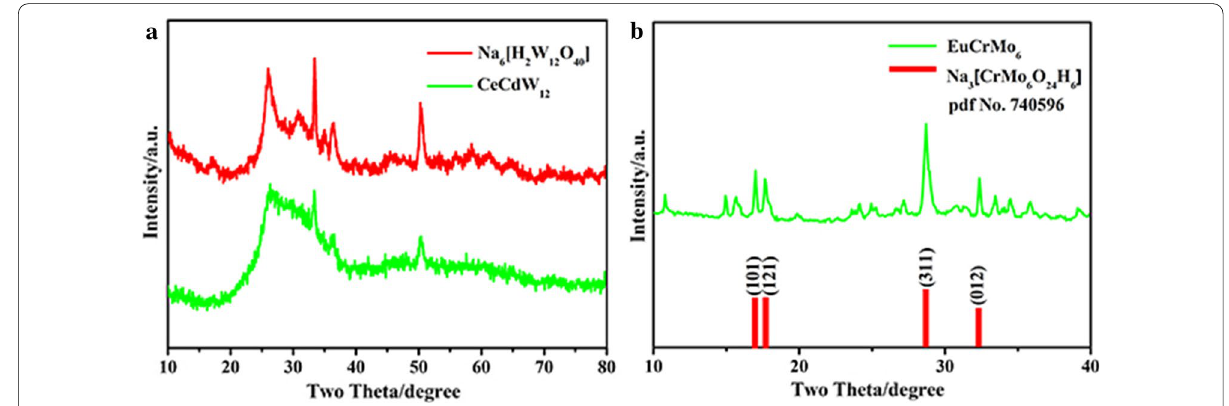
Fig. 5 XRD patterns of CeCdW 12 nanoflowers and EuCrMo 6 microflakes